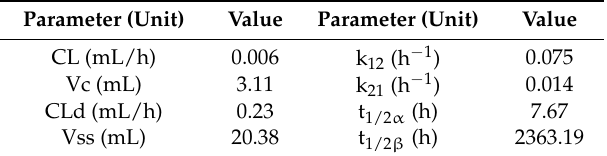
Table 1. Pharmacokinetic parameters of quantum dots (QDs) after intravenous injection fitted by a two-compartment